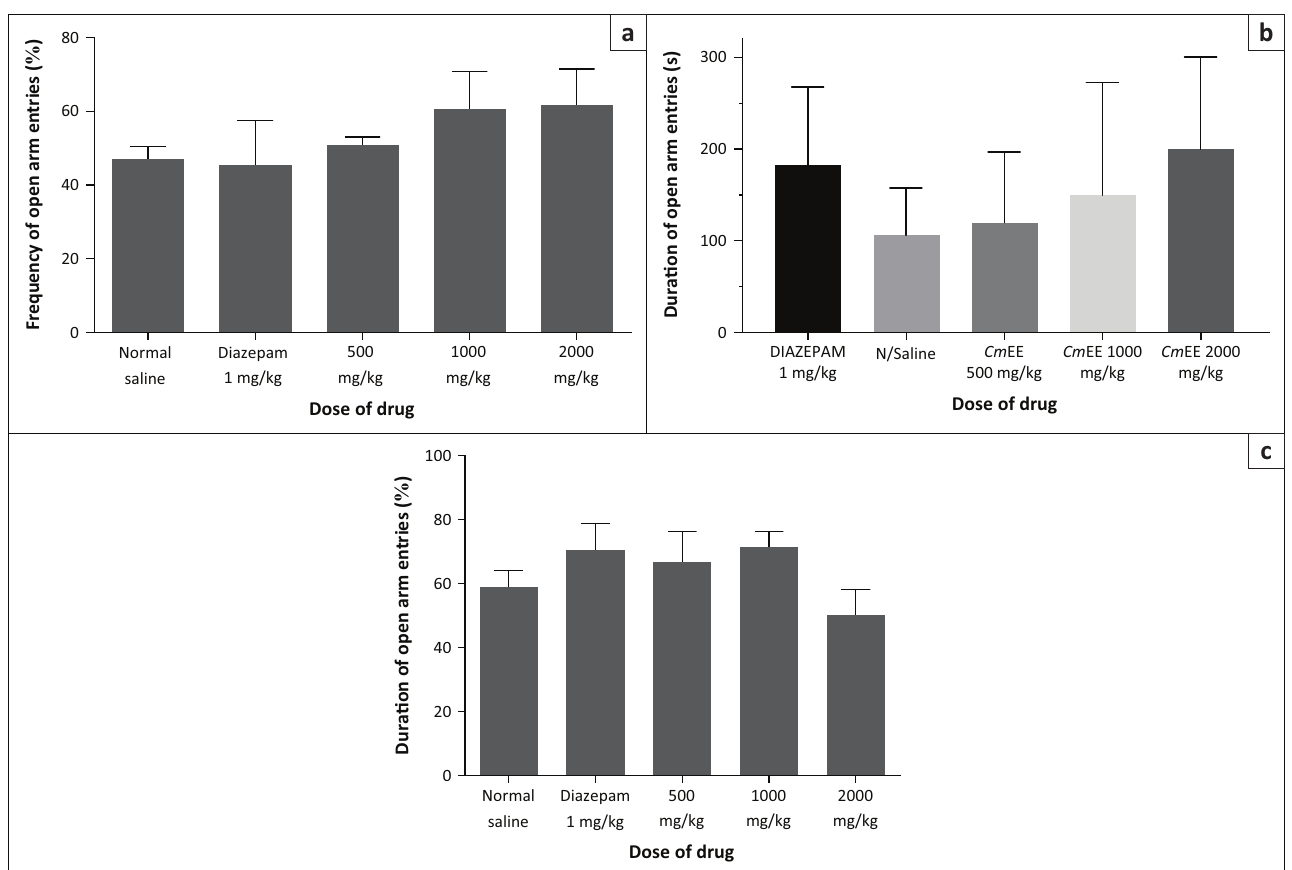
FIGURE 3: Assessment of the frequency and duration of entries into the open arm of the elevated plus maze in mice administered 500, 1000 and 2000 mg/kg of ethanolic leaf extract of Combretum micranthum , 1 mg/kg diazepam and normal saline in mice. (a) The frequency (b) duration in seconds and (c) percent of the total time spent in the open arms of the elevated plus maze in response to ethanolic leaf extract of C. micranthum , diazepam and normal saline in mice. Data are expressed as mean ± standard error of mean (S.E.M.) and analysed using Student’s- t test with p < 0.05 considered as significant. TABLE 2: Index of open arm avoidance values of ethanolic extracts of controls and ethanolic extract of Combretum micranthum. Treatment